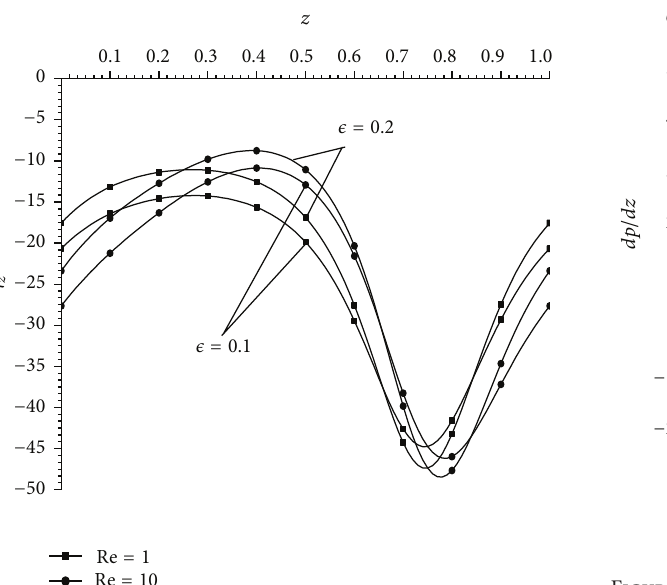
Figure 10: Variation of pressure gradient versus 𝑧 with different values of 𝛿 and 𝜖 at Wi = 0.05 , 𝑄 = 0.5 , 𝜙 = 0.4 , and Re = 2 .